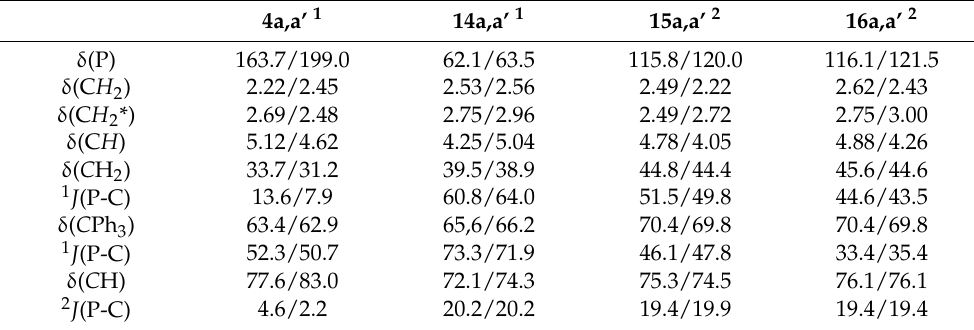
CH 2 -protons arising from C 3 -substituted regioisomers.